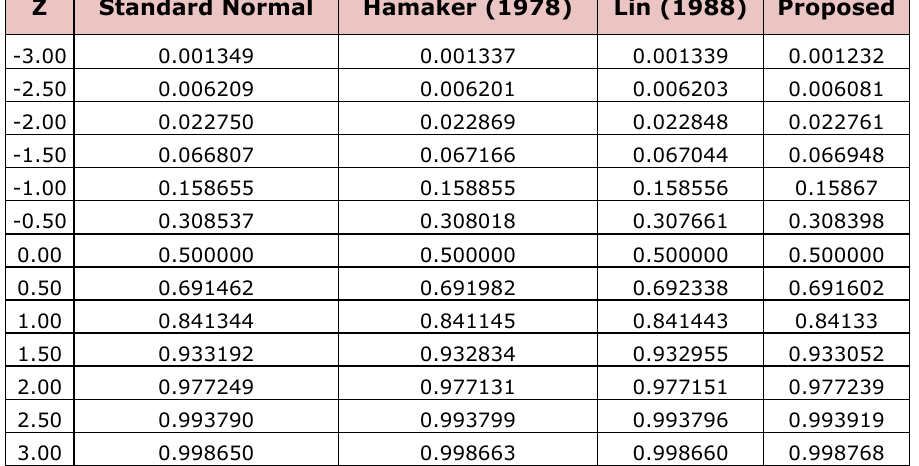
Table 2. “Illustration of the proposed logistic approximation vs. the cumulative normal distribution and that of Hamaker (1978) and Lin (1988)”.